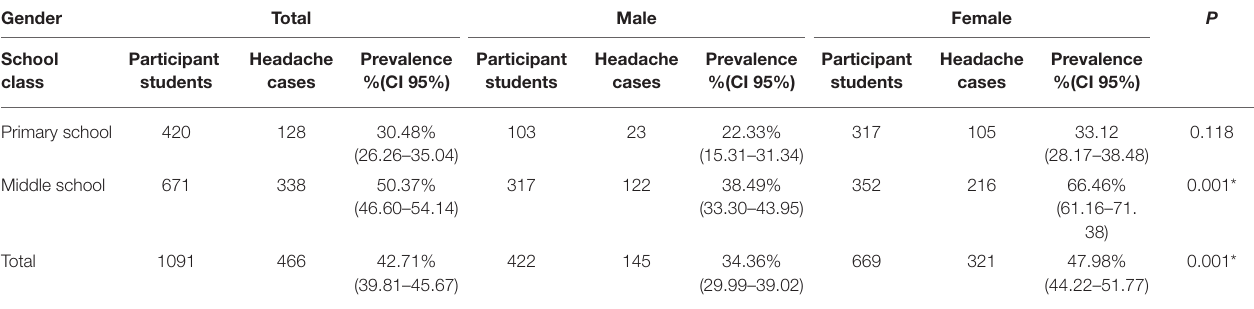
TABLE 5 | One-year prevalence of Primary headache disorders stratified by school stage and gender. Gender